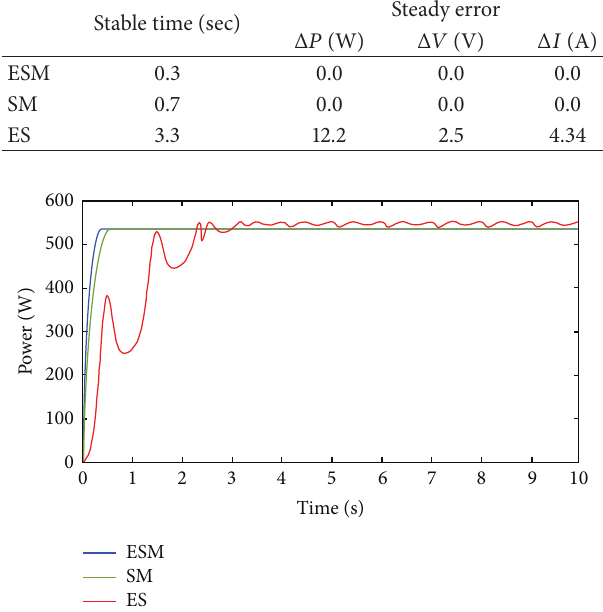
Figure 10: Comparison of control performance of ESM, SM, and ES